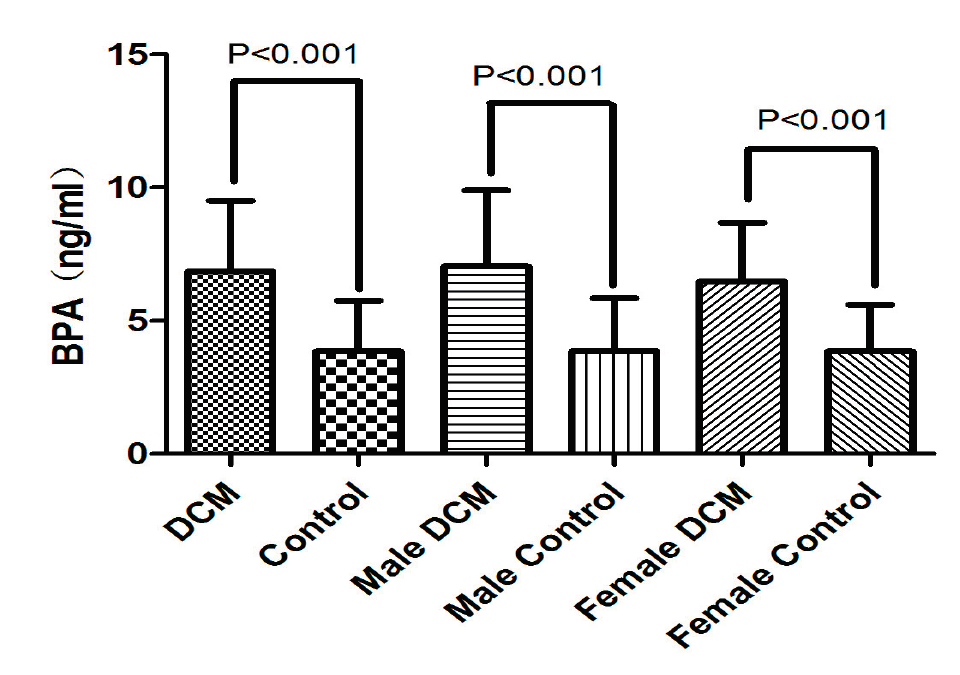
Figure 1. Serum BPA levels in DCM patients and controls, as well as in male and female subgroups.